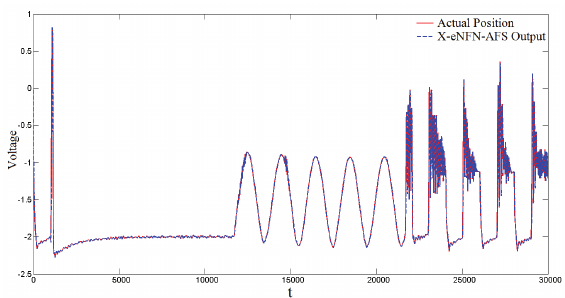
Figure 4. X-eNFN-AFS prediction of the sphere position.